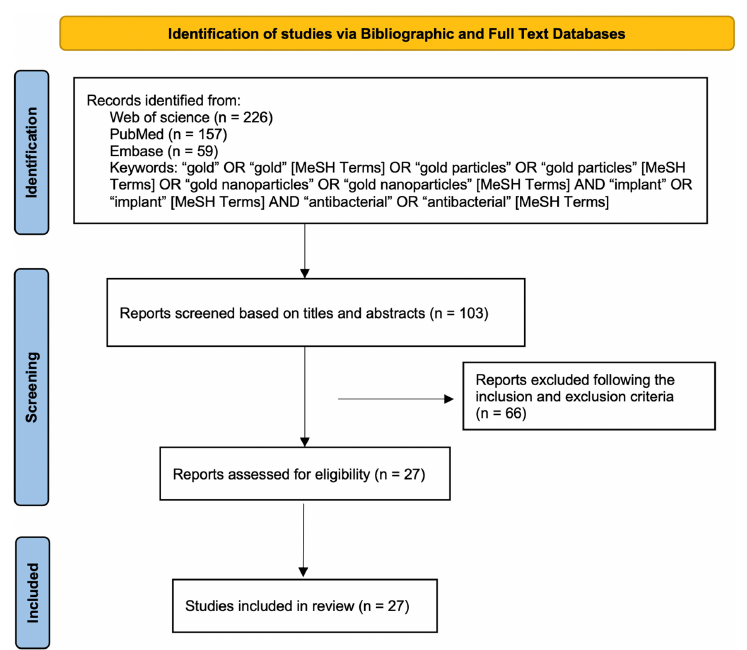
Figure 1. PRISMA flow diagram.